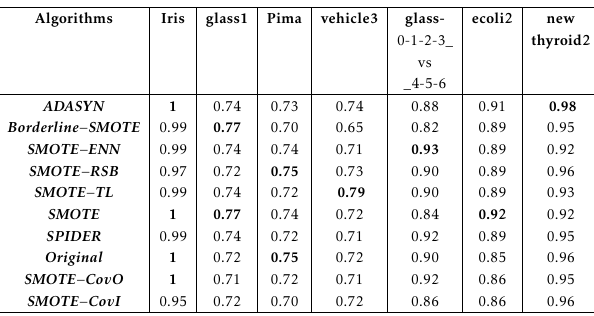
Table 2. AUC of the data balancing algorithms with generation of oversampling classes of the state-of-the-art, CovI and CovO Algorithms Iris glass1 Pima vehicle3